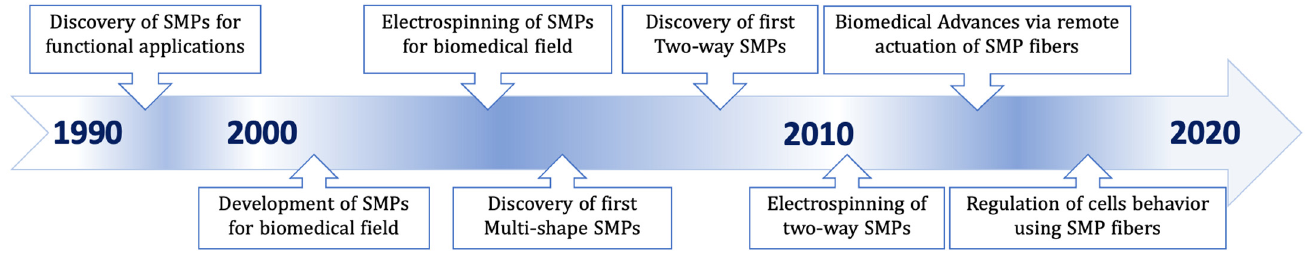
Figure 1. A timeline chart of the progress in shape memory polymers (SMPs) discoveries, electrospinning, and biomedical applications.